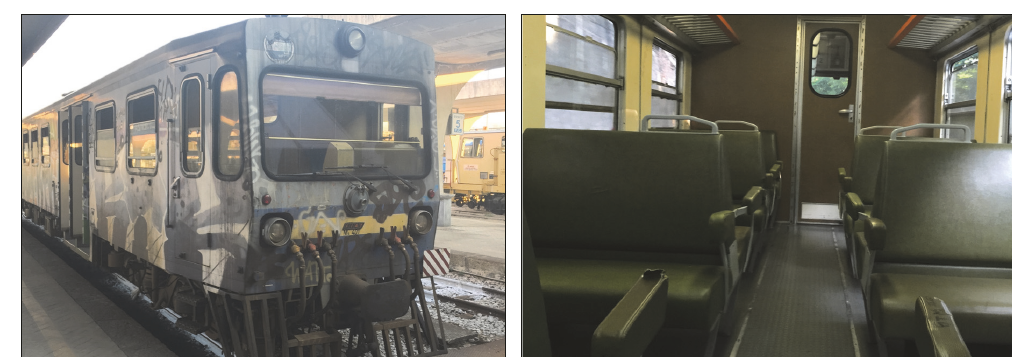
Figure 11: M4.400 FIAT